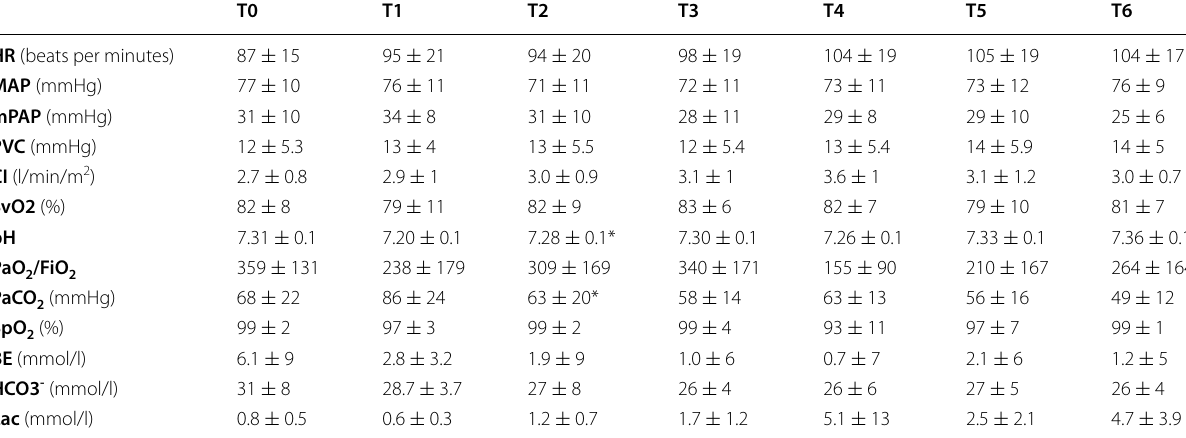
Cardiorespiratory parameters in different phases of LT ECCO2R was started between T1 and T2 clamping of the pulmonary artery, T3 after 40 min from clamping, T4 after 90 min from clamping, T5 after 120 min from clamping, T6 declamping of the pulmonary artery * p < 0.05 VS single lung ventilation